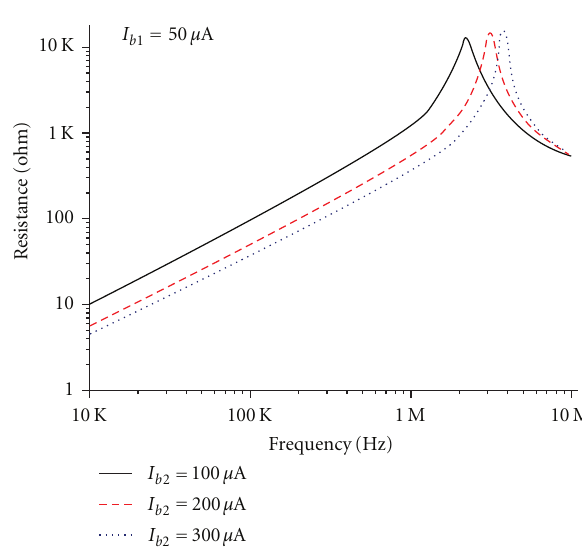
Figure 7: Magnitude plot for proposed floating inductor.